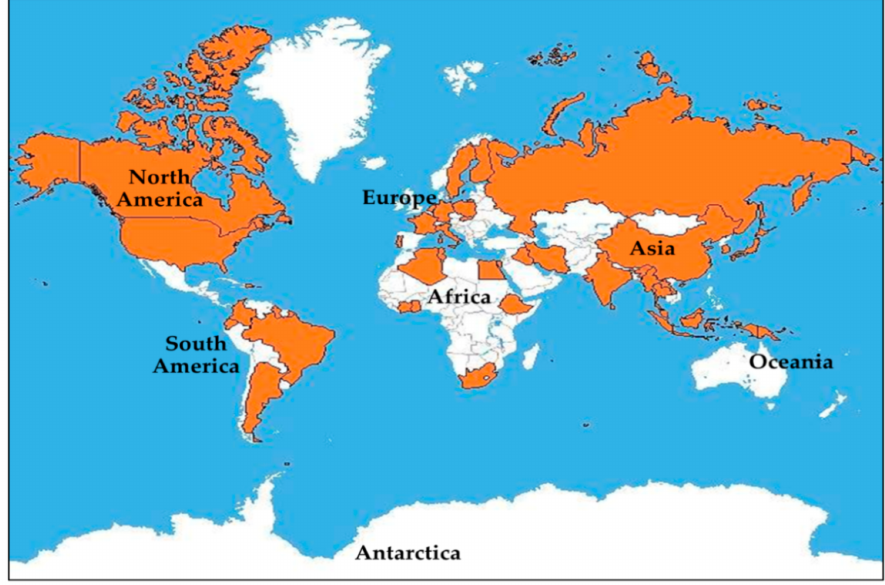
Figure 2. Global distribution of Wickerhamomyces species. The countries where Wickerhamomyces species have been discovered are indicated in orange